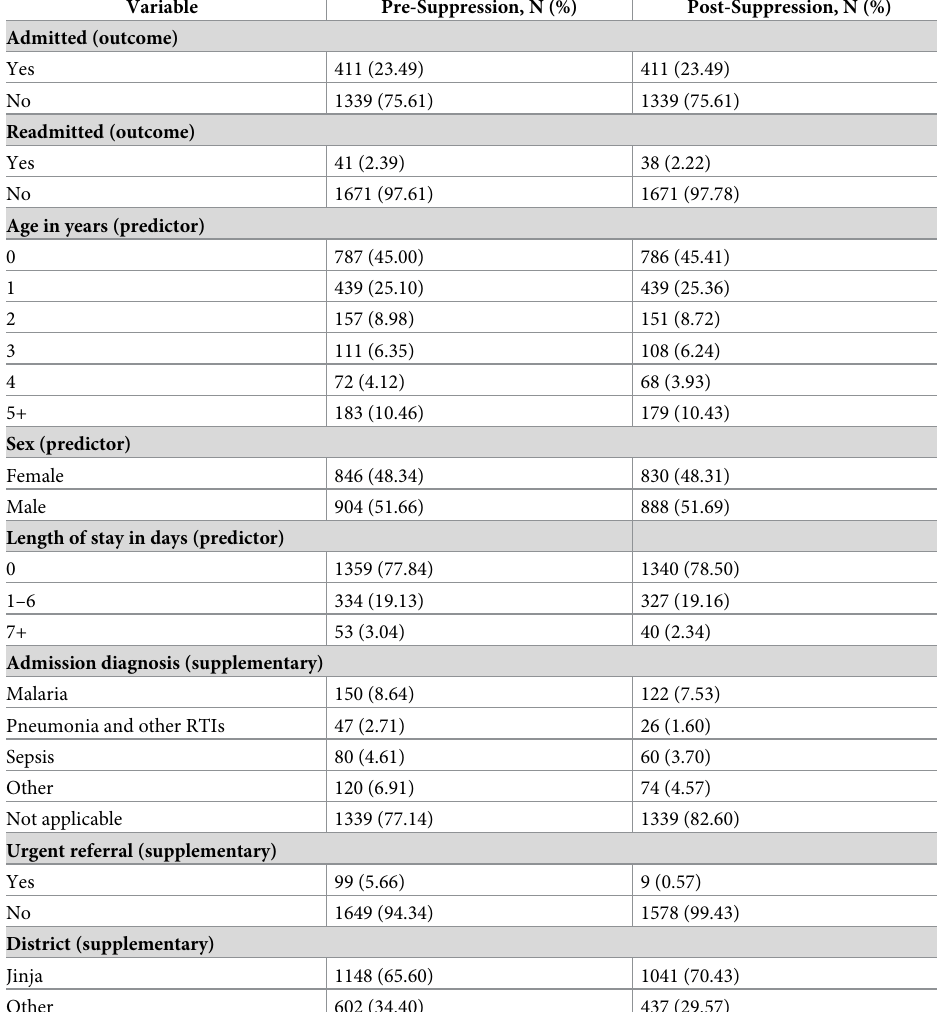
Table 8. Distribution of response values for variables pre-and-post